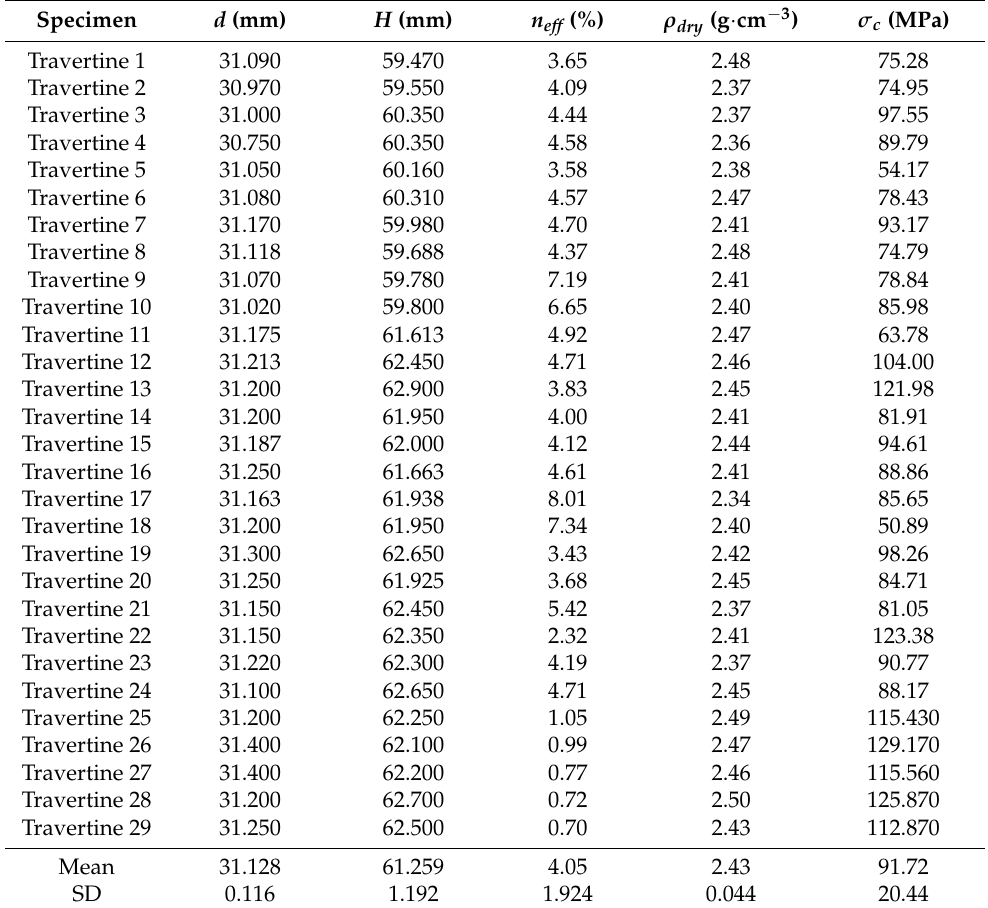
Table 6. Results of the uniaxial compressive strength, density, and porosity tests on